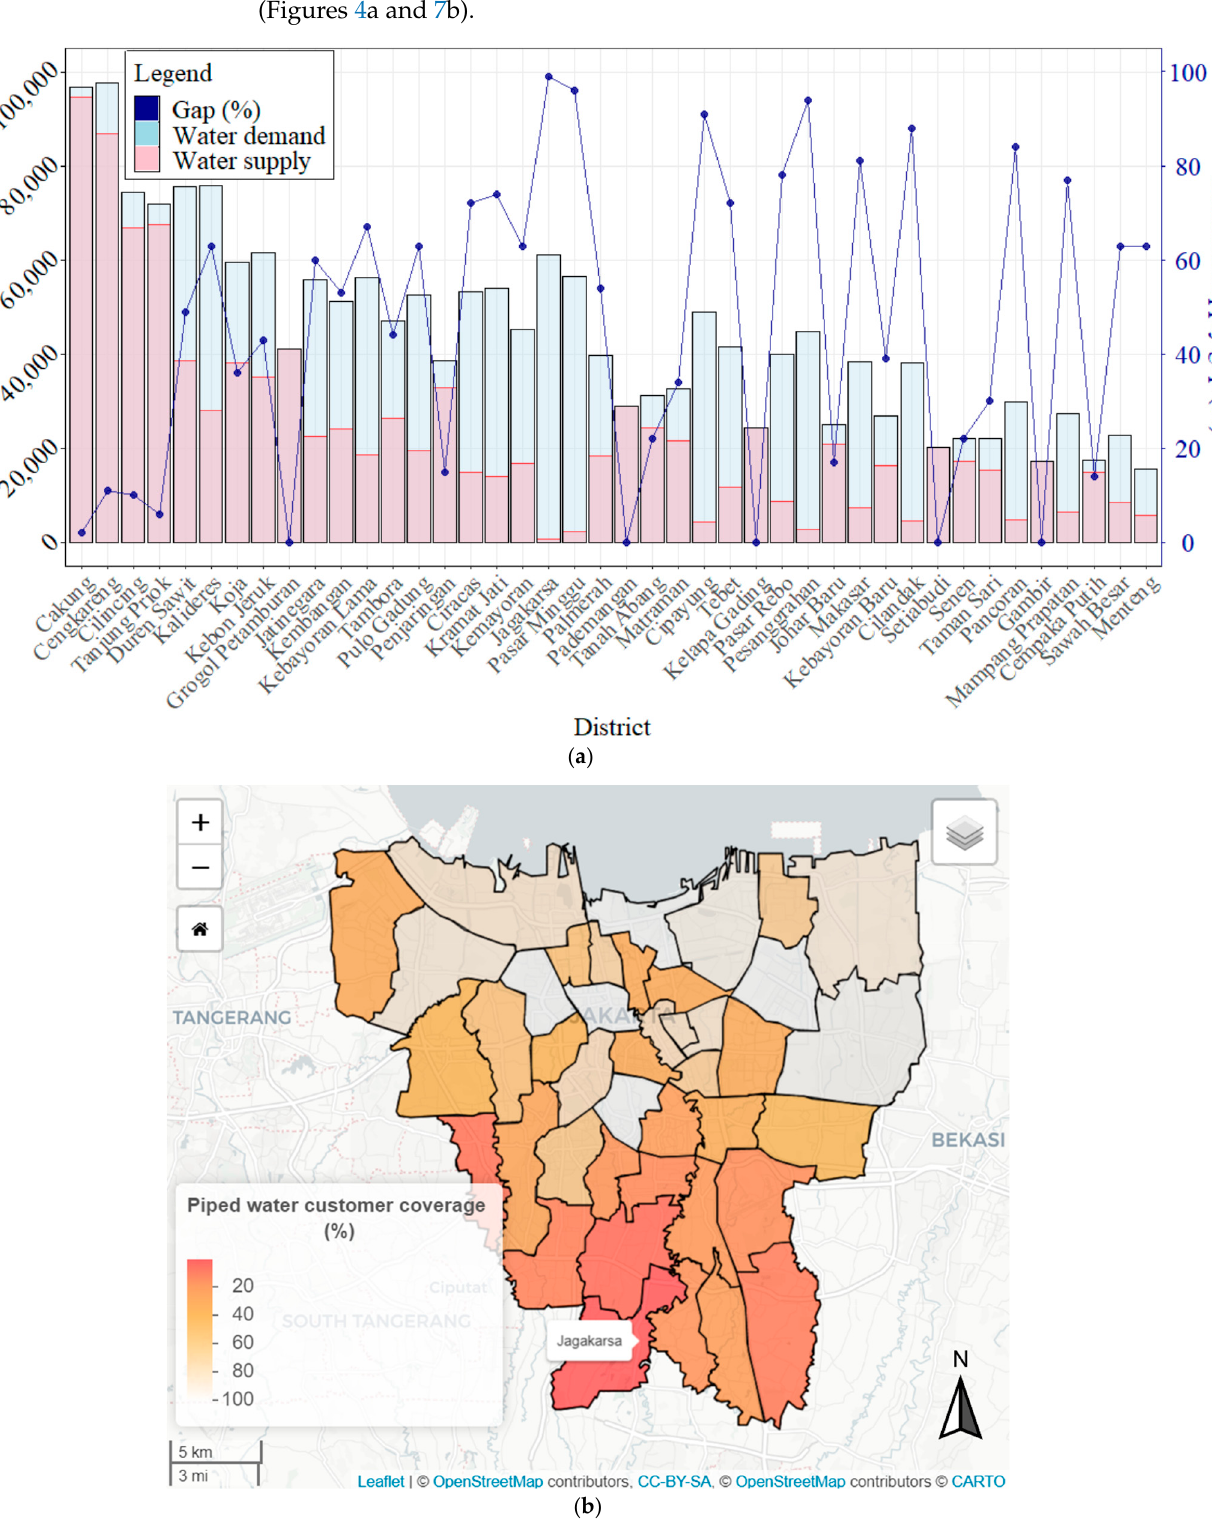
Figure 7. ( a ) Water demand and supply and the demand–supply gap per district. ( b ) Percentage of the population served by piped water per district.